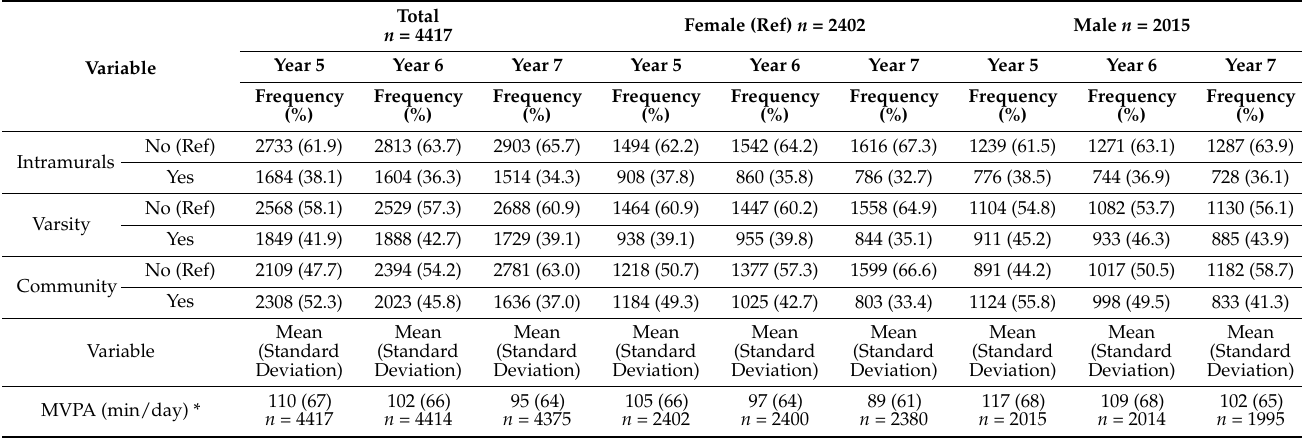
Table 3. Descriptive Statistics for Time-Varying Student-Level Characteristics for the sample ( n = 4417) from Year